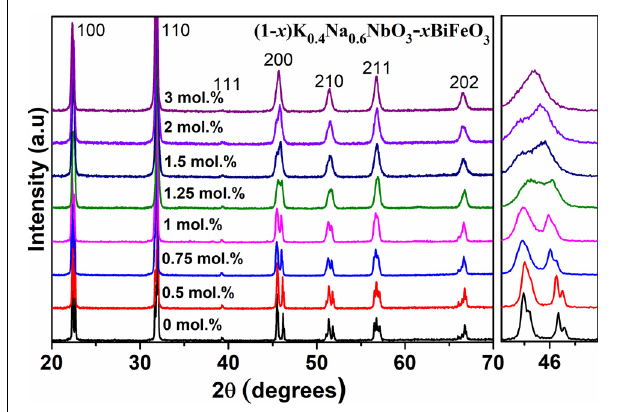
FIGURE 1 | Room temperature XRD traces of (1- x )K 0 . 4 Na 0 . 6 NbO 3 – x BiFeO 3 ( x = 0–3 mol.%)